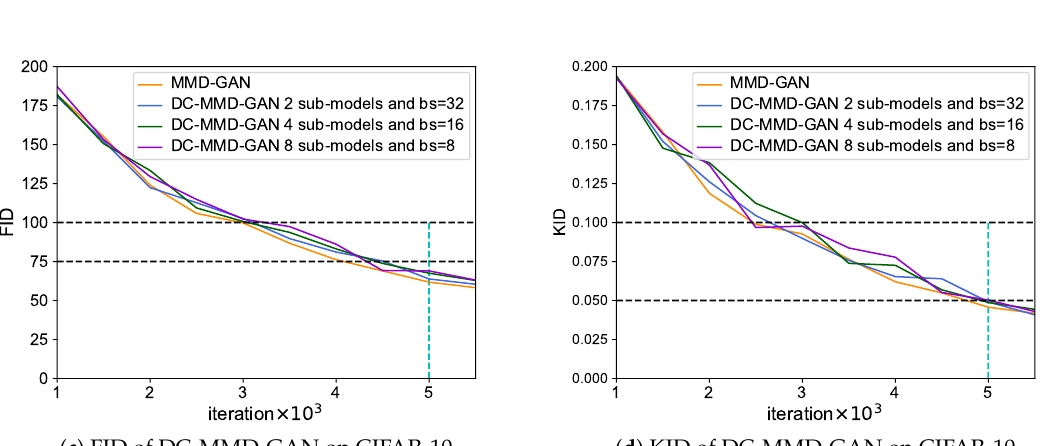
Figure 9. The evolution of FID and KID as the number of iterations increases when trained on CIFAR-10. Compared to the score of MMD-GANs with batch size equaling to cm, DC-MMD-GANs reach competitive score with less training time. DC-MMD-GANs accelerate the training